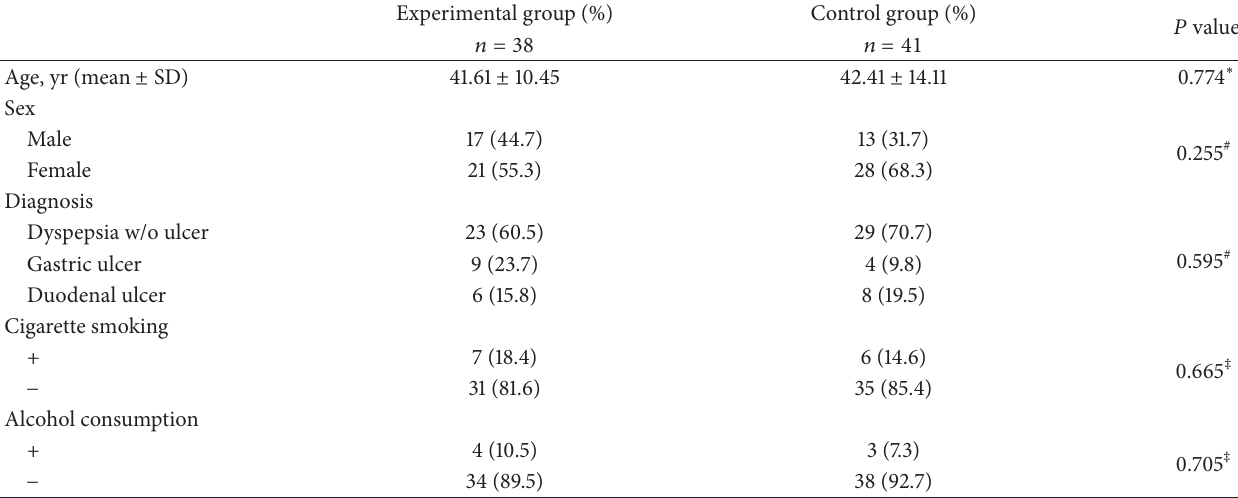
Table 1: Patients demographics and clinical characteristics.